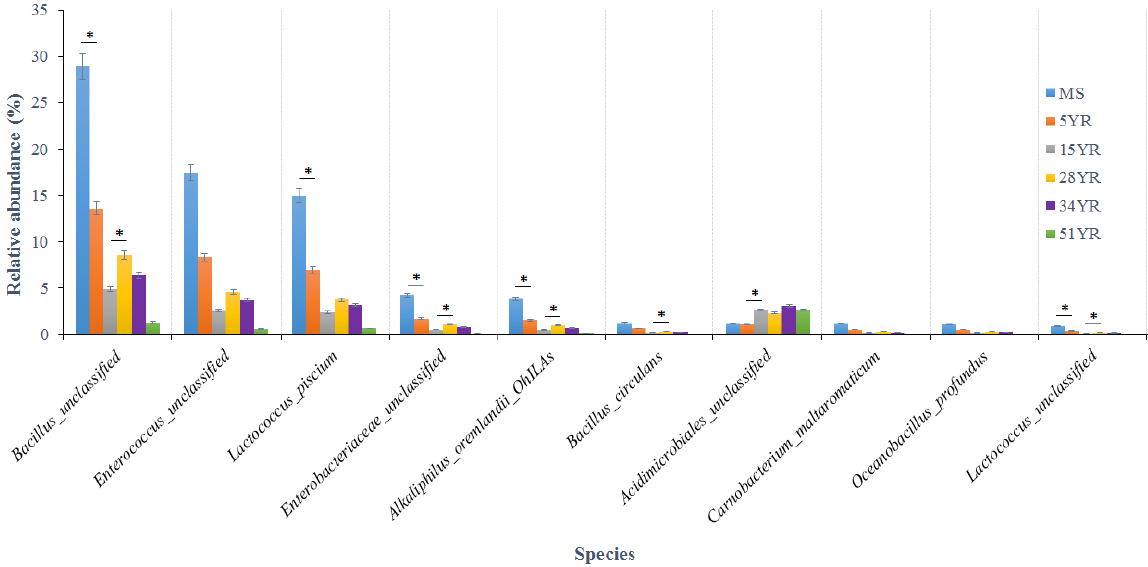
Figure 8. Abundant species ( > 10% of total OTUs) and low-abundance species (1% < of total OTUs < 10%) of bacteria distributed in different ages of BSCs. Data are defined at a 3% OTU genetic distance. Data are presented as mean ± standard deviation; n = 3 per BSC samples. Paired t tests (BSC samples) were used to assess the significance between the adjacent ages of BSCs. ∗ P ≤ 0.05; ∗∗ P ≤ 0.001. MS, 5YR, 15YR, 28YR, 34YR and 51YR represent mobile sand, 5-, 15-, 28-, 34- and 51-year-old BSCs, respectively.